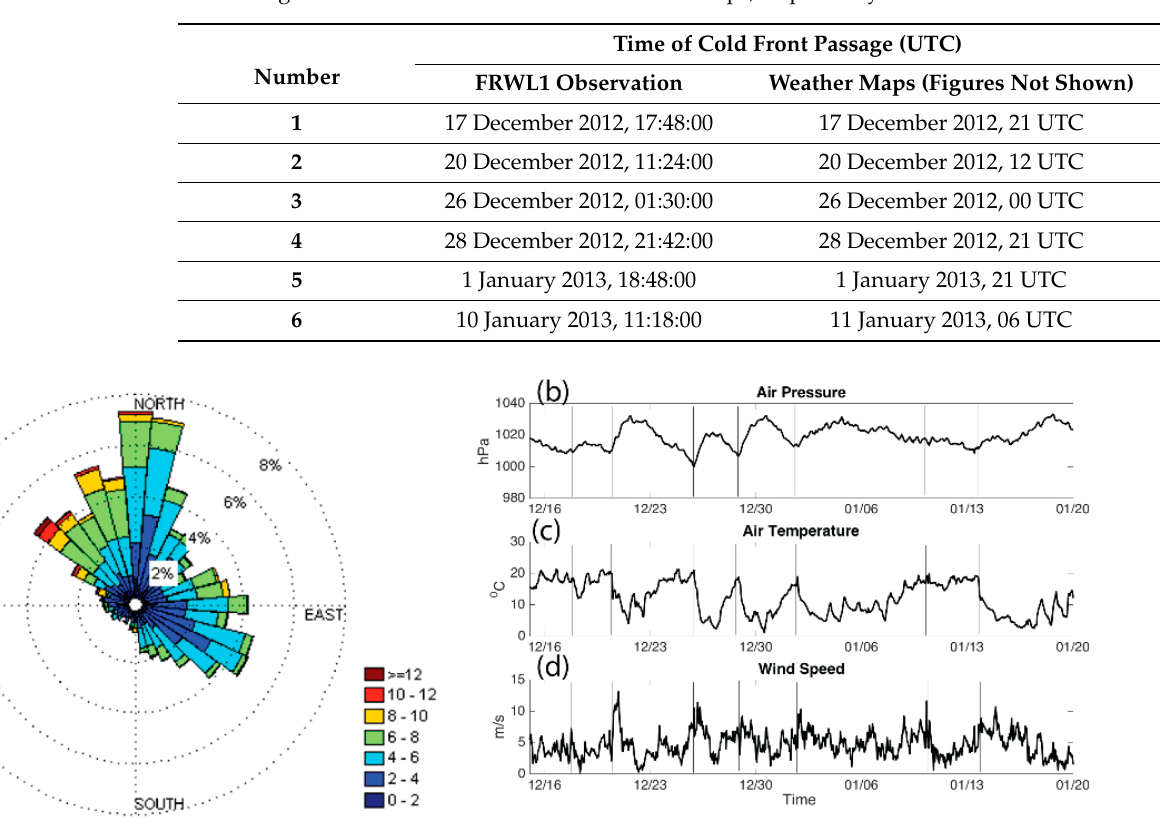
Table 3. Skill score (SS) value of current velocity for 4 stations (* indicates not available or applica-